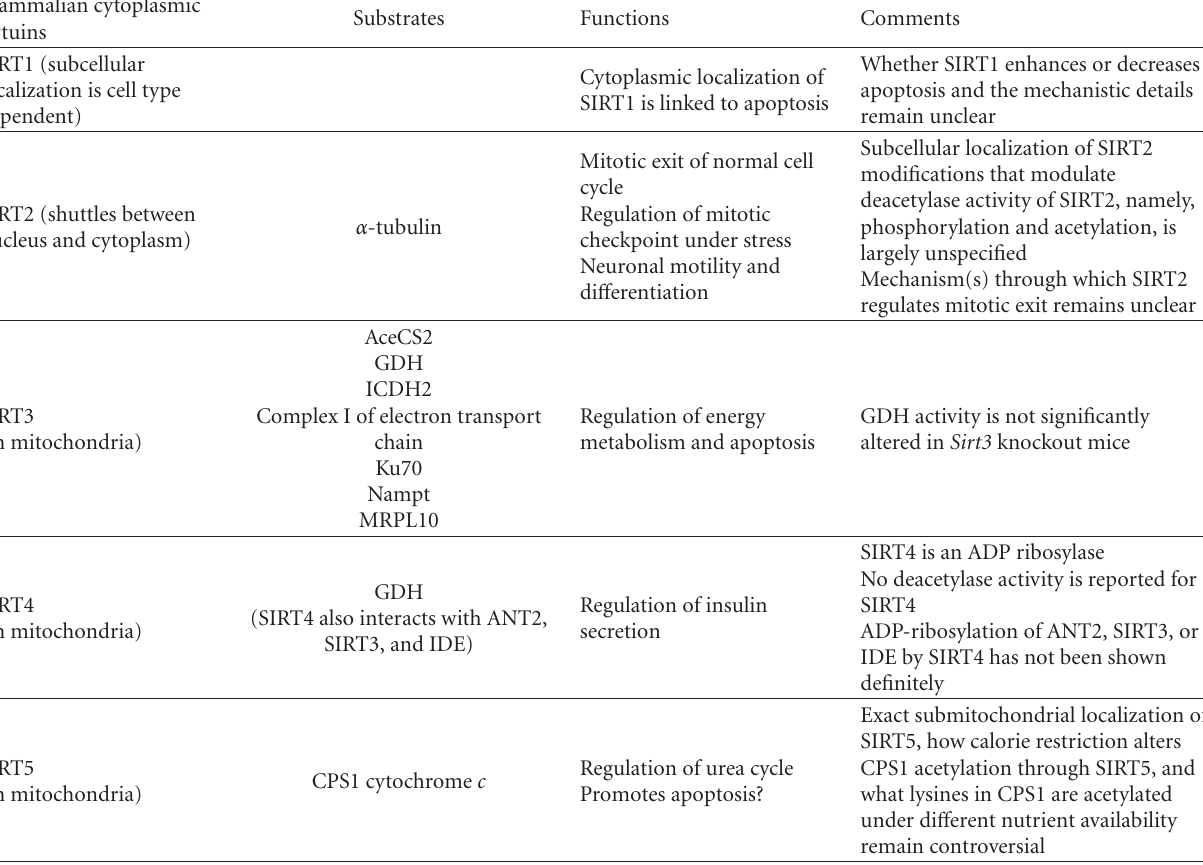
Table 4: Cytoplasmic sirtuins, their substrates in the cytoplasm, and their